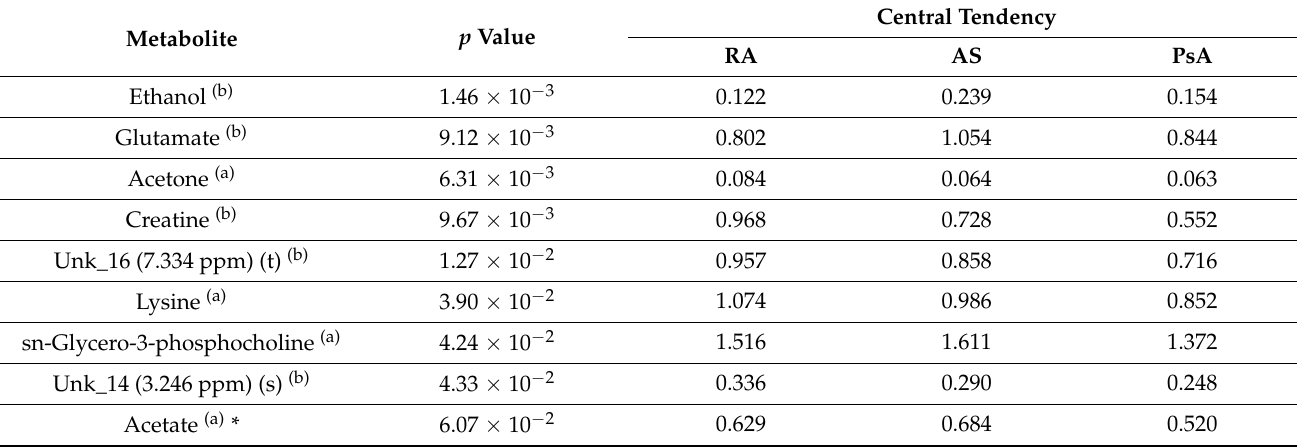
Table 6. Summary of univariate analysis for RA, AS, PsA comparison after 6 months of anti-TNF treatment.